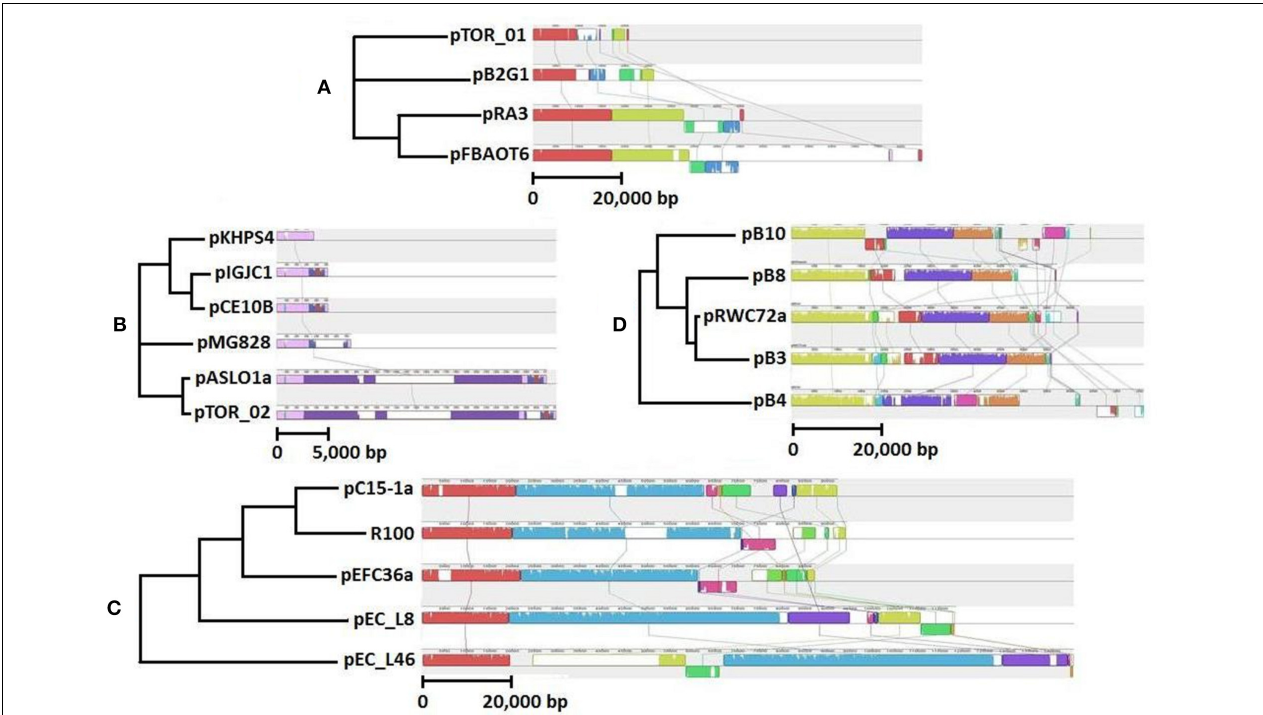
FIGURE 2 | Comparative analysis of (A) pTOR_01 and (B) pTOR_02, (C) pEFC36a and (D) pRWC72a by mauve alignment, showing evolutionary relationships with related plasmids, Genbank accession numbers are in brackets. Same color represents regions of highest similarity. The selected sequences are closely related Inc U plasmids pFBAOT6 (CR376602), pRA3